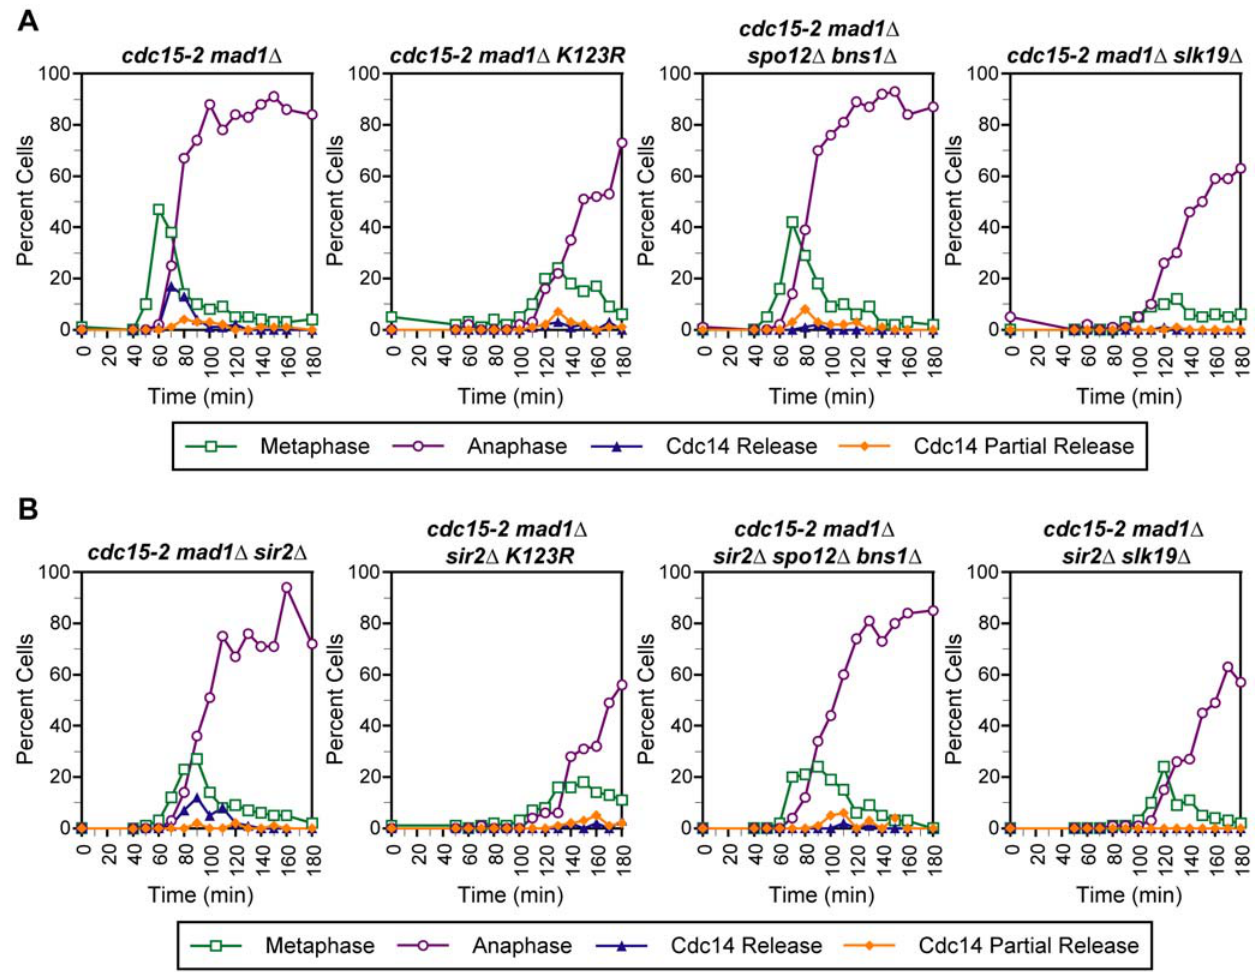
Figure 6. Sir2 is not responsible for Cdc14 release defects of htb1-K123Rhtb2-K123R and FEAR network mutants. (A,B) Time course analysis. The temporal profile of Cdc14 release from nucleolar sequestration is displayed for strains of the indicated genotypes. Time courses were performed as described in Figure 2C.